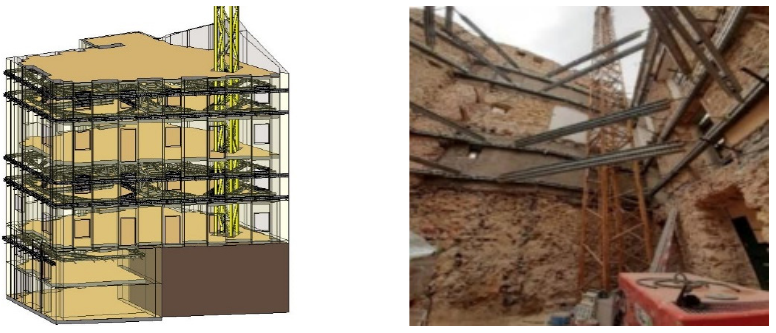
Figure 12. Comparison of the BIM model with the real construction work.